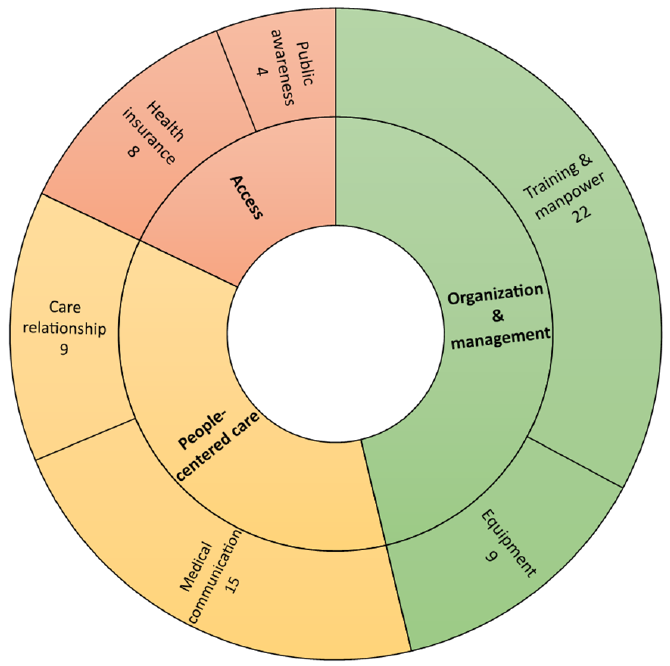
Figure 4. The number of studies focusing on each theme and respective sub-themes.